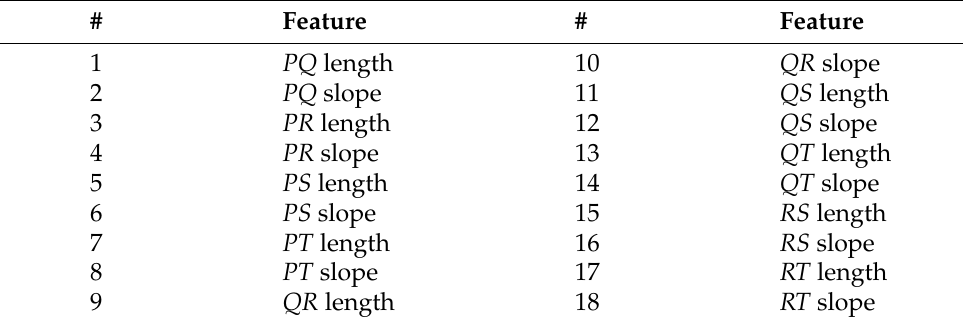
Table 2. Features extracted from